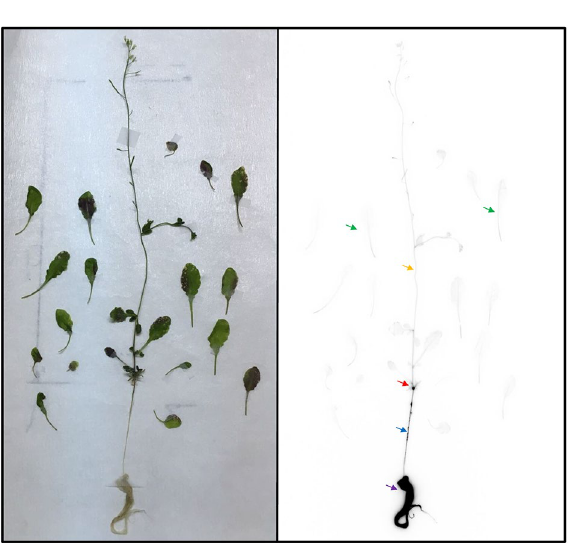
Figure 6. Autoradiography of static 74 As in shoots and roots of A . thaliana exposed to 0.2 μM As including 2 kBq of 74 As-labeled AsV for 168 h. Shoots (green arrow), main-stem (yellow arrow), shoots base (red arrow), primary root (blue arrow) and lateral roots (purple